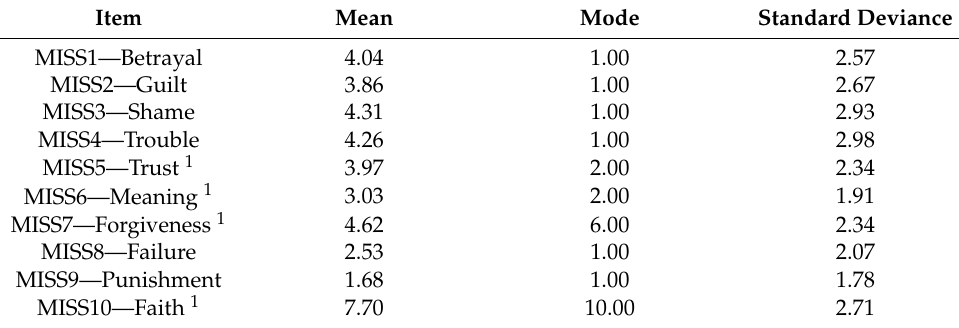
Table 2. Descriptive item statistics of